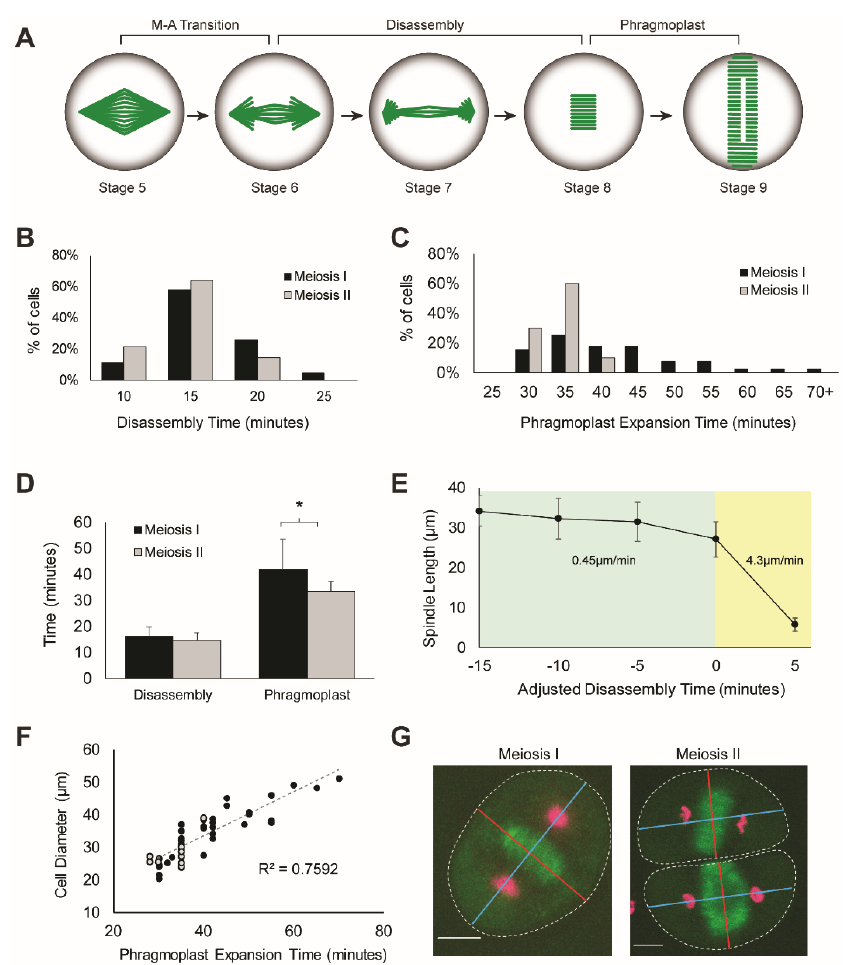
Figure 5. Dynamics of meiotic spindle disassembly and phragmoplast expansion. ( A ) Meiotic spindle disassembly and phragmoplast expansion is grouped into four stages. Metaphase cells (stage 5) undergo the metaphase-to-anaphase transition (M-A transition) and begin depolymerization of kinetochore microtubules (stage 6) to pull chromosomes apart. Kinetochore microtubules are fully disassembled when chromosomes reach the spindle poles (stage 7) and disassembly concludes when interpolar microtubules disappear (stage 8). Phragmoplast formation begins with a nucleating disk (stage 8) that expands radially outward toward the cell cortex (stage 9). ( B ) Histogram of spindle disassembly times (stage 6–8) in meiosis I (black) and meiosis II (gray) cells. ( C ) Histogram of phragmoplast expansion time (stage 8–9) in meiosis I (black) and meiosis II (gray) cells. ( D ) The average disassembly time and phragmoplast expansion time; error bars represent standard deviation. * denotes p -value < 0.001, t -test ( E ) Spindle length plotted through disassembly time; time is adjusted with T = 0 representing the inflection point between slow (green) and fast (yellow) depolymerization phase (yellow). Displayed depolymerization rates are the calculated slope of each phase; error bars represent standard deviation. ( F ) Linear correlation of cell diameter and phragmoplast expansion time. R 2 value calculated for total cell population of meiosis I (black) and meiosis II (gray) cells ( n = 47). ( G ) Phragmoplasts expansion axis (red line) is perpendicular to former spindle axis (blue); correlation plot in ( F ) uses phragmoplast-oriented cell diameter (red line). Scale bar: 10µm.